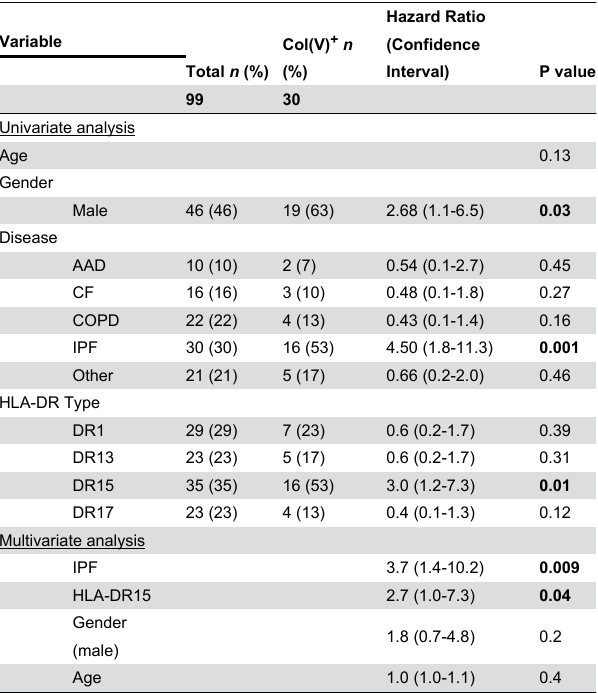
(PPGPQGPIGYPGPRG) and p789 (PGPRGVKGADGIRGL (Figure 3A, blue) adjacent to the DR1/15 shared binding peptide p799 (Figure 3, yellow), while p629 (DRGFDGLAGLPGEKG) bound only to HLA-DR1 (18.2% control, Figure 3B,